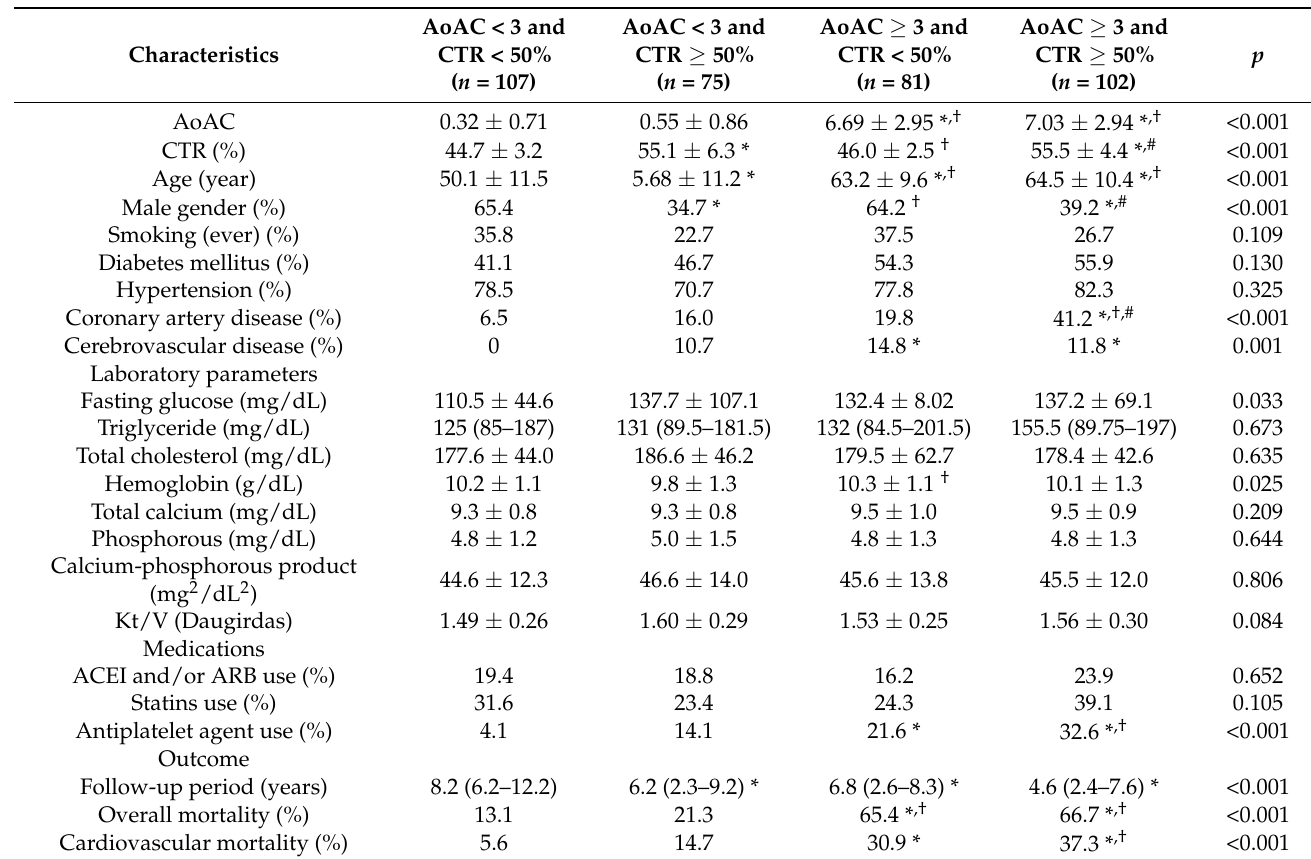
Table 1. Comparison of clinical characteristics among study